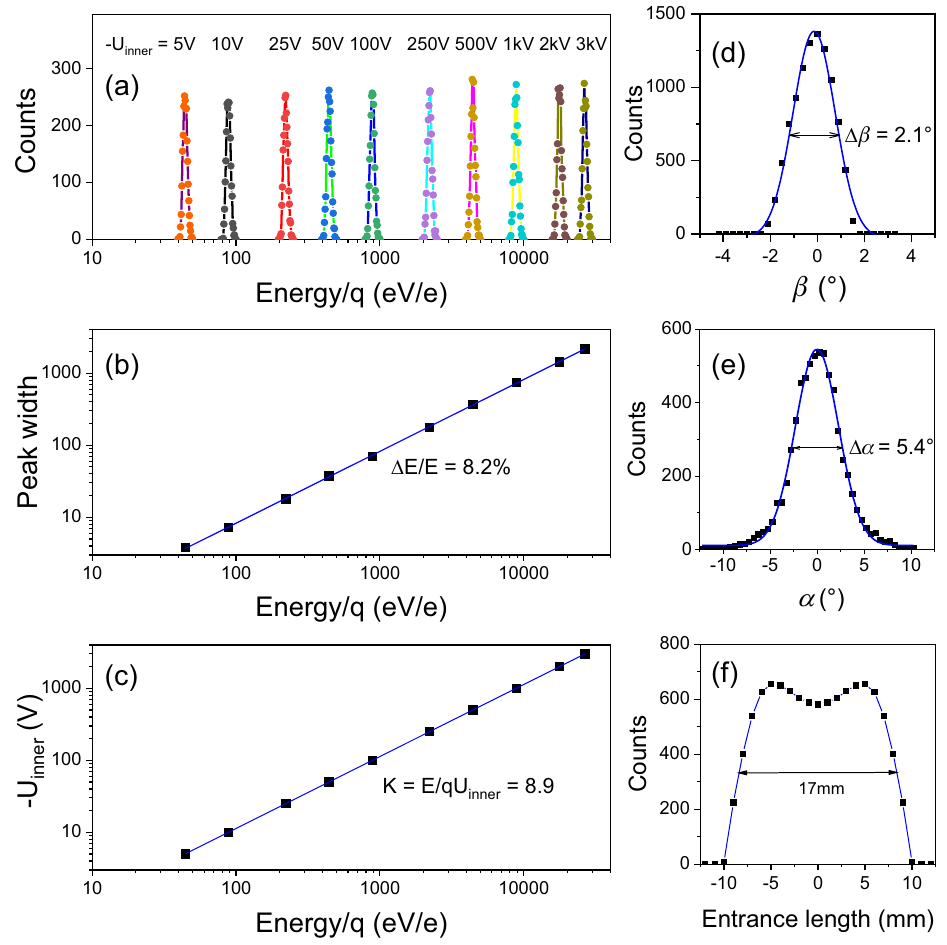
Figure 4: Simulation results: ( a ) energy response spectrum, ( b ) energy resolution, ( c ) analyzer constant K , ( d ) elevation angle response, ( e ) azimuth angle response, and ( f ) e ff ective length of the entrance aperture for the incident